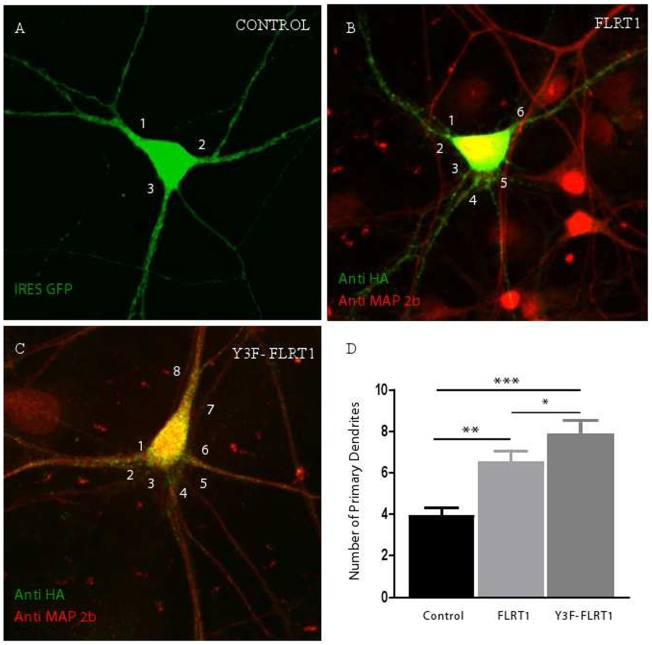
FLRT1 and Y3F-FLRT1 increase the number of primary dendrites in rat hippocampal neurons.(A–C) Representative confocal microscopic images of the number of primary dendrites in hippocampal neurons transfected with IRES GFP control vector (A), FLRT1 (B) and Y3F-FLRT1 (C) The number of primary dendrites increased when the neurons were transfected with FLRT1 and Y3F-FLRT1 compared to the control (D) Graphical representation of the average number of primary dendrites emerging from the soma under each condition There was a significant increase in primary dendrites in both the FLRT1-and Y3F-FLRT1transfected neurons compared to the control (P<00001, one-way analysis of variance and P = 00008, Kruskal-Wallis Test) Tukey's Multiple Comparison Test also revealed that there was a significant difference between control and FLRT1 (P<001, **), control and Y3F-FLRT1 (P<0001, ***) and FLRT1 and Y3F-FLRT1 (P<005, *) Data derived from several coverslips and two separate experiments.